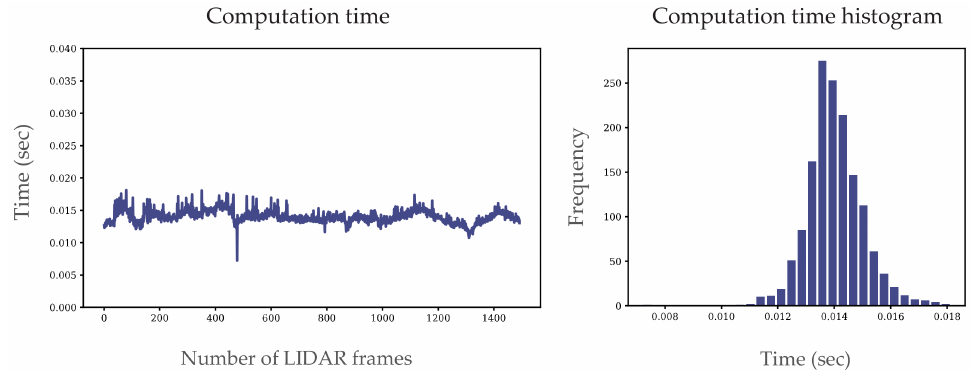
Figure 12. Results of the proposed approach (computation